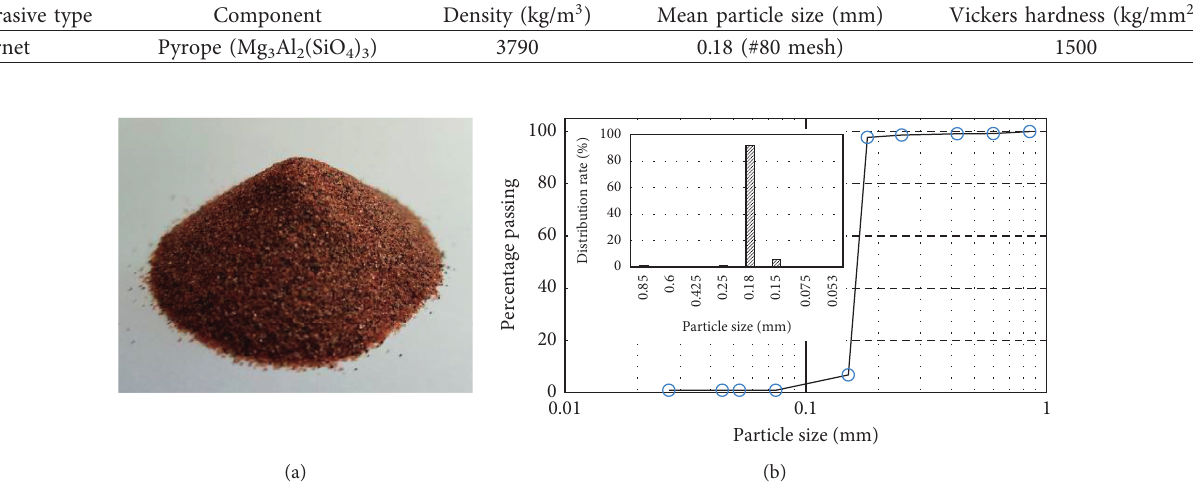
Figure 5: Abrasive for the experiment: (a) India garnet; (b) particle size distribution. Table 3: Properties of the target rock.